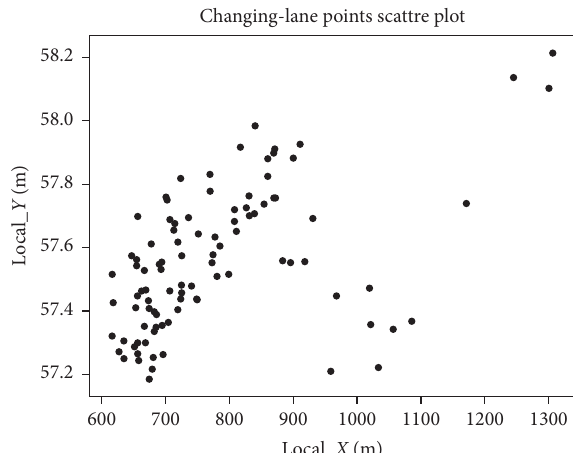
Figure 9: Lane-changing